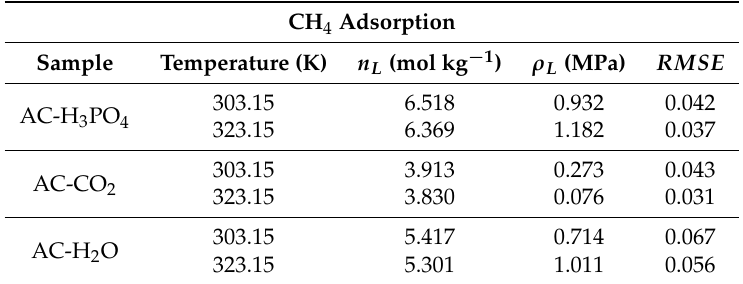
Table 3. Langmuir fitting parameters for the CH 4 adsorption